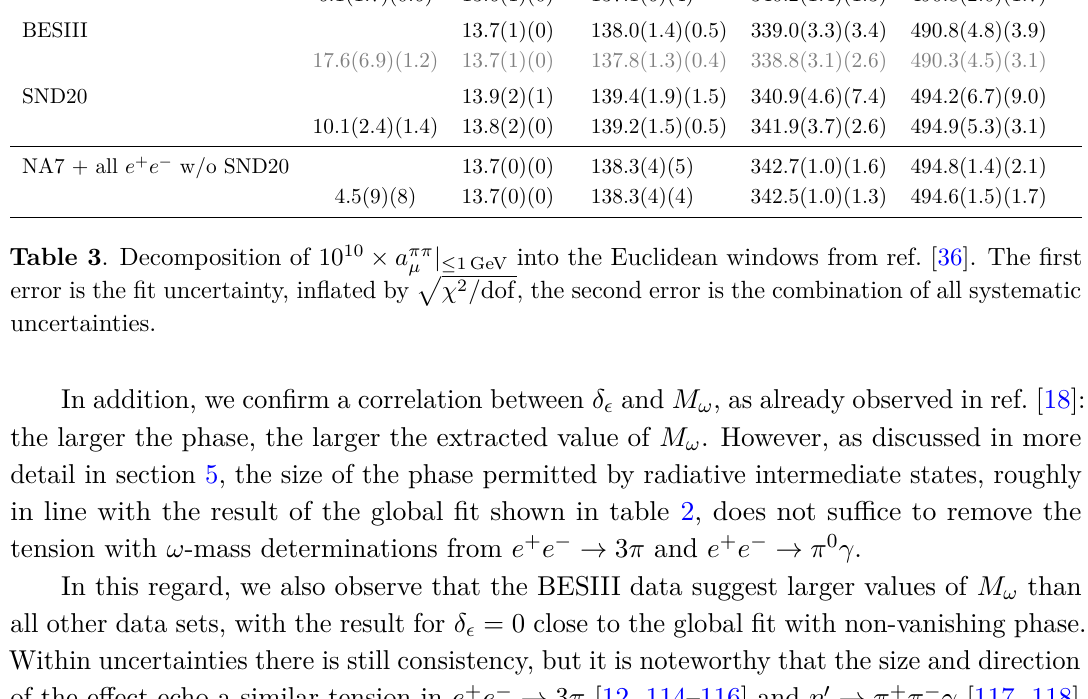
Table 3 . Decomposition of 10 10 × a ππ error is the fit uncertainty, inflated by